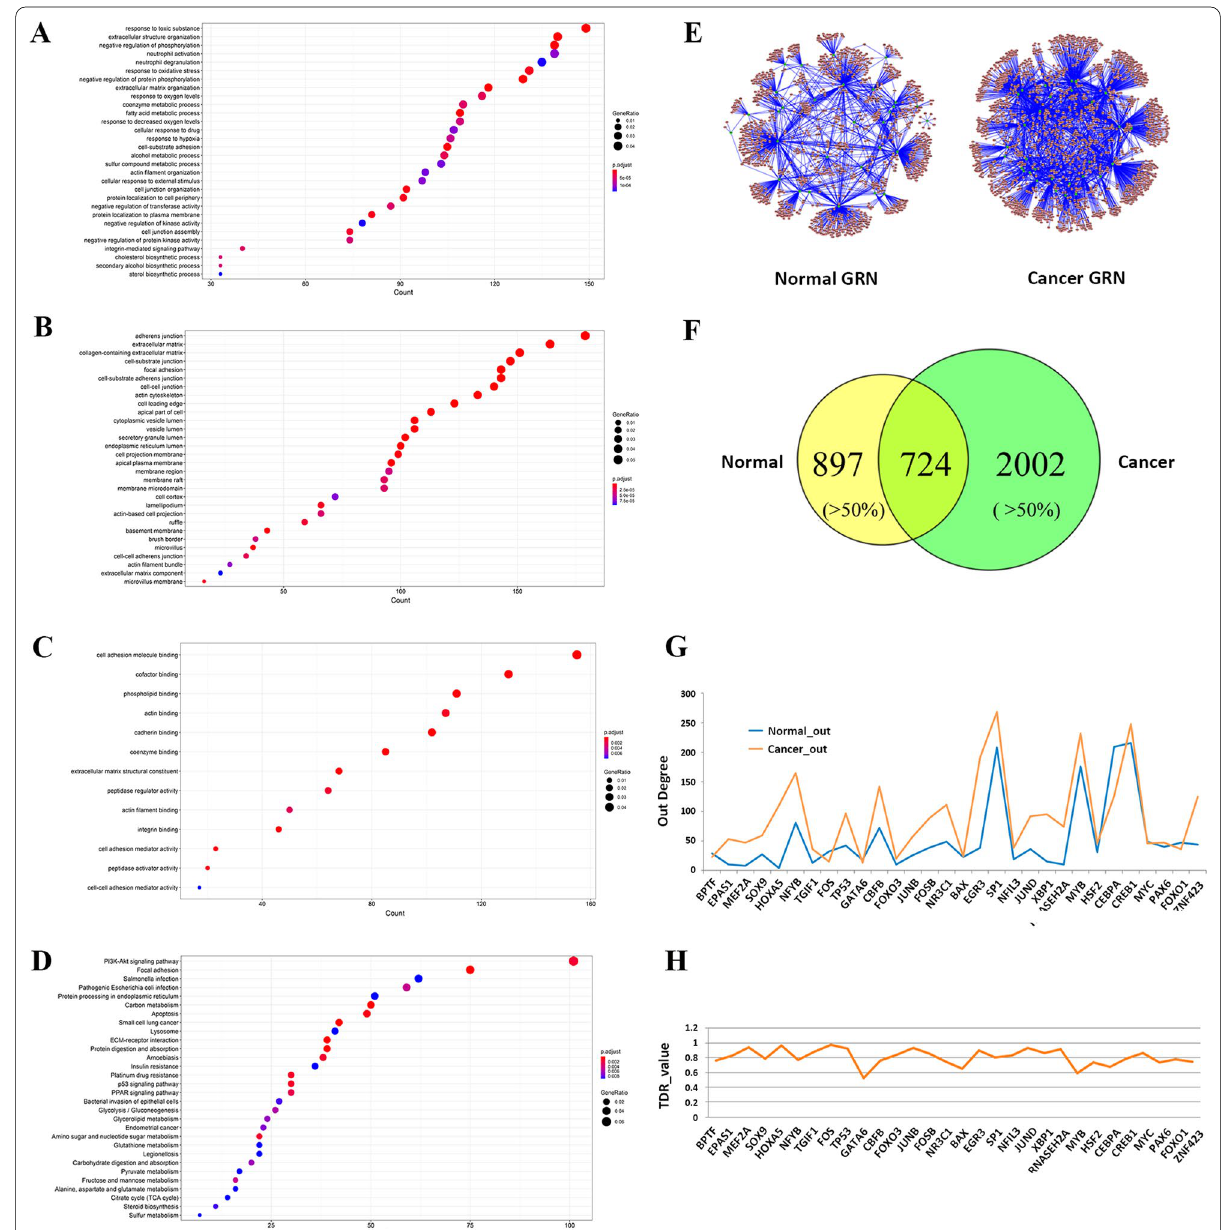
Fig. 1 Stage‑specific gene regulatory networks and GO analysis. GO analysis of the DCGs in the terms of ( A ) Biological processes; ( B ) Cellular components; ( C ) Molecular function and ( D ) KEGG pathway analysis. E Gene regulatory network (GRN) in normal (left) and in cancer (right). F Venn diagrams illustrate the number of regulatory relationships involved in two stage‑specific GRNs. G Out‑degree distribution of 30 TFs involved in two stage‑specific GRNs. H Distribution of TDR values of 30 TFs in two stage‑specific